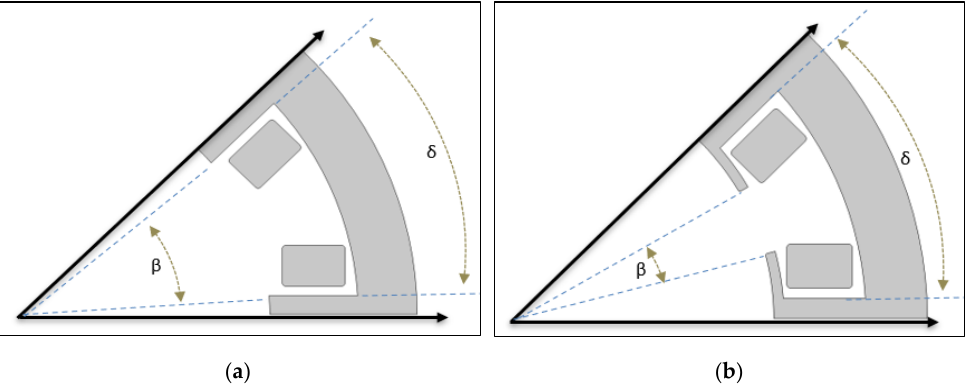
Figure 12. Slot opening, β and slot pitch, δ . ( a ) Slot opening for an open slot design. ( b ) Slot opening for a semi-closed slot design.